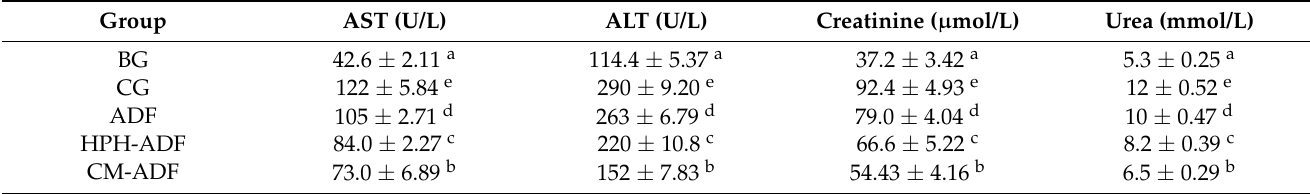
Table 5. Serum AST, ALT, creatinine and urea levels in rats.